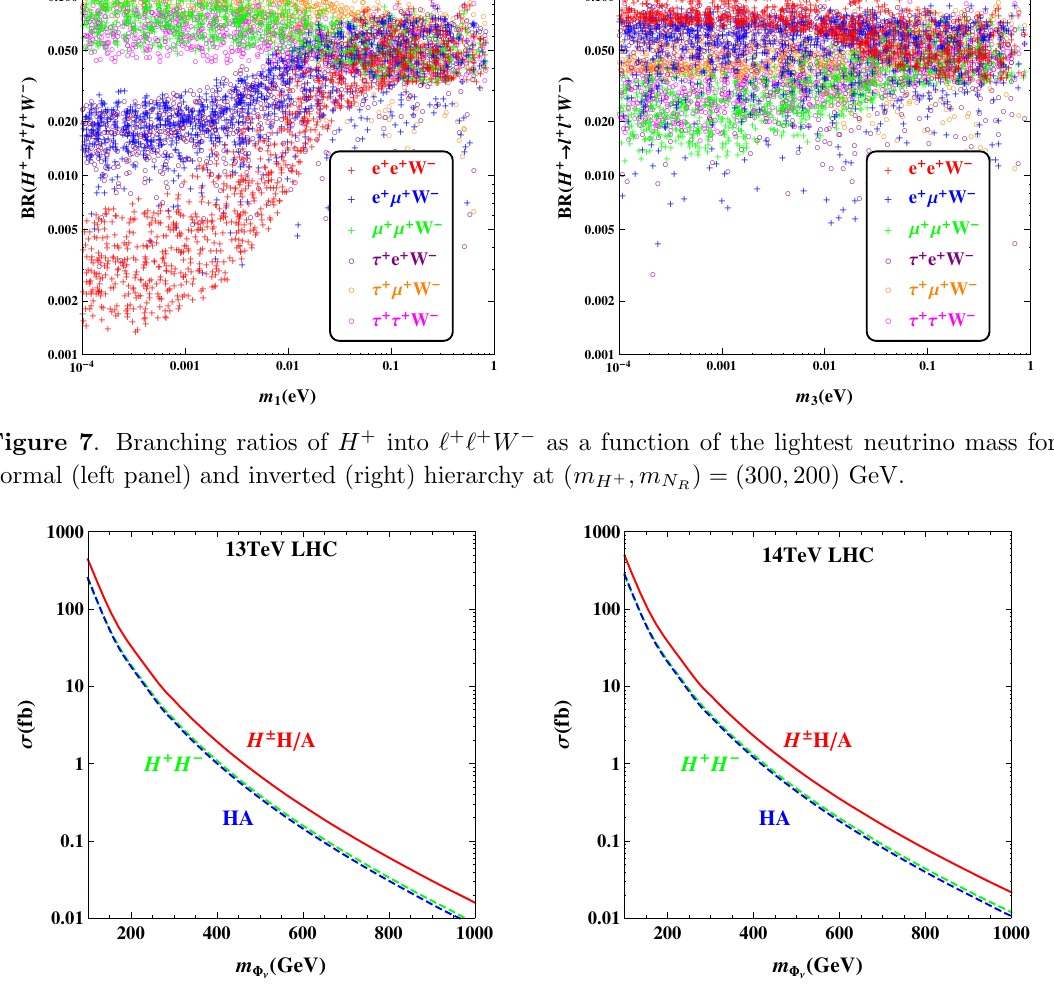
Figure 8 . Cross sections for the pair and associated production of the neutrophilic scalars at 13 (14) TeV LHC as a function of their mass m